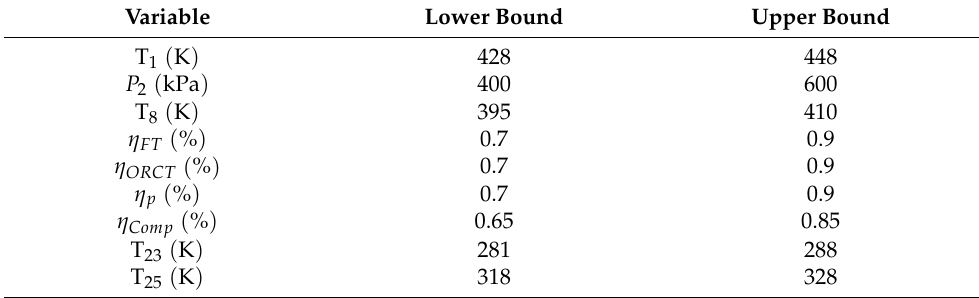
Table 8. Design variables and their